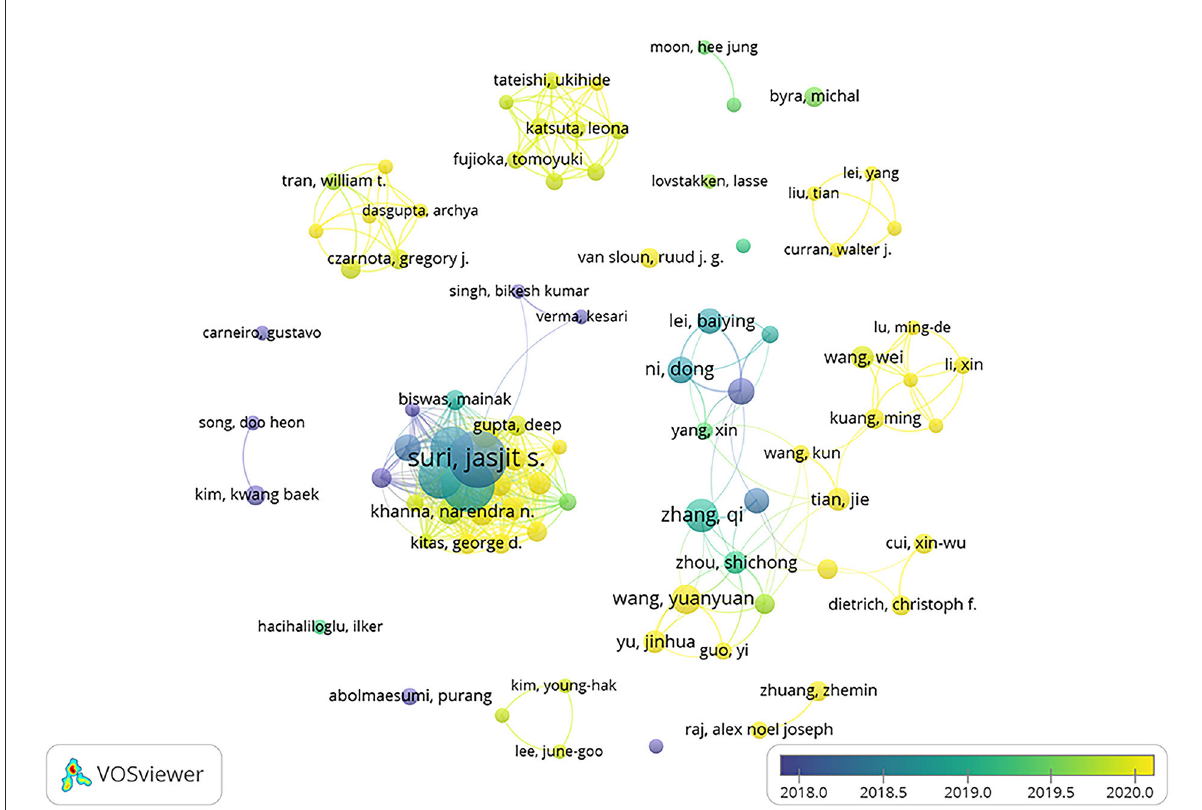
FIGURE8 The network of top 10 authors produced in VOSviewer. The size of circles reveals the publications. The lines between the circles represent the connections between the authors.